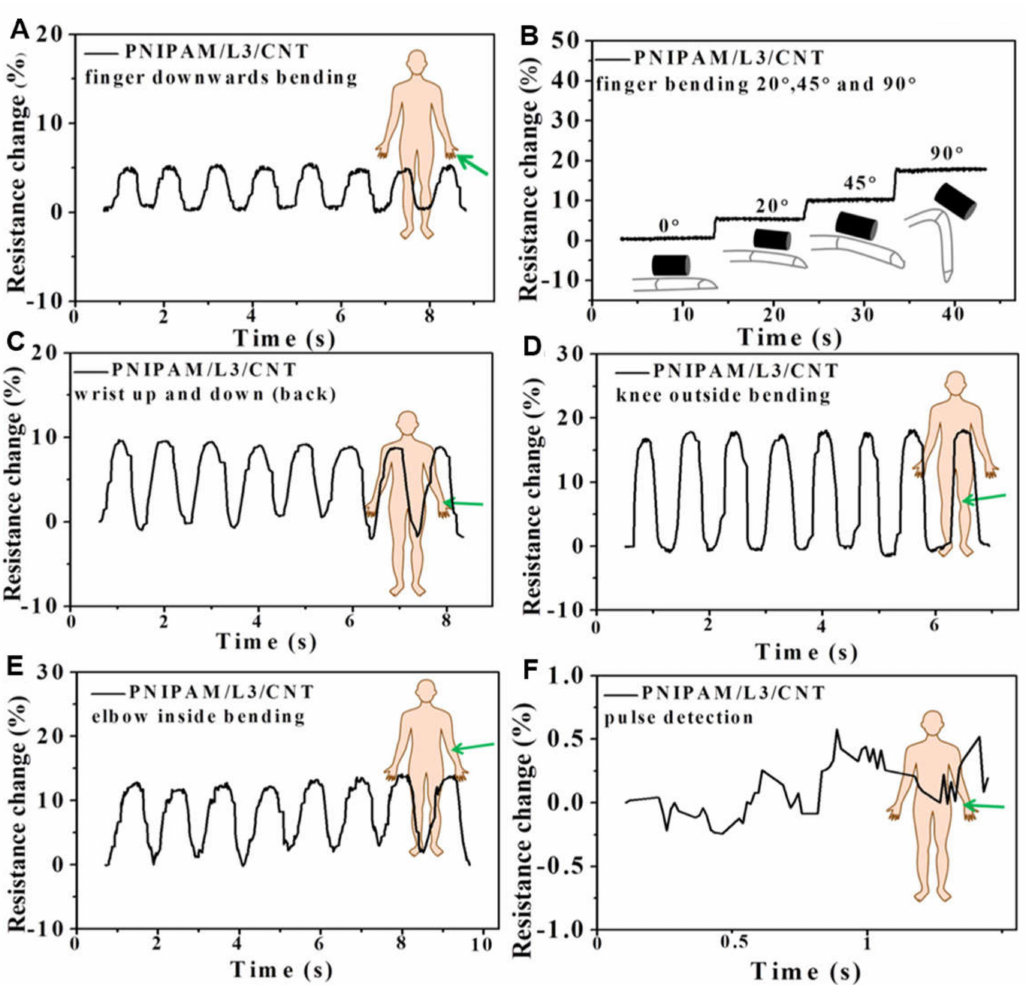
Figure 6. Relative resistance changes for N -isopropylacrylamide (PNIPAM) / laponite (L) / carbon nanotube (CNT) hydrogels of ( A , B ) index finger two direction bending, ( C ) wrist motions, ( D ) knee bending, ( E ) elbow bending, and ( F ) pulse detection [8]. Reprinted from [8] with permission from American Chemical